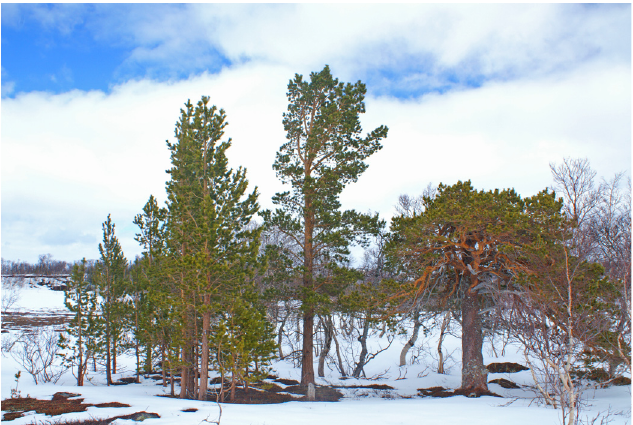
Figure 26: Old-established pine (to the right), about 300 ye- ars old and marking the treeline about a century ago. It has produced at least three generations of offspring in its close surroundings during the past century. Mt. Storsnasen, 670 m a.s.l. 22 July 2006.